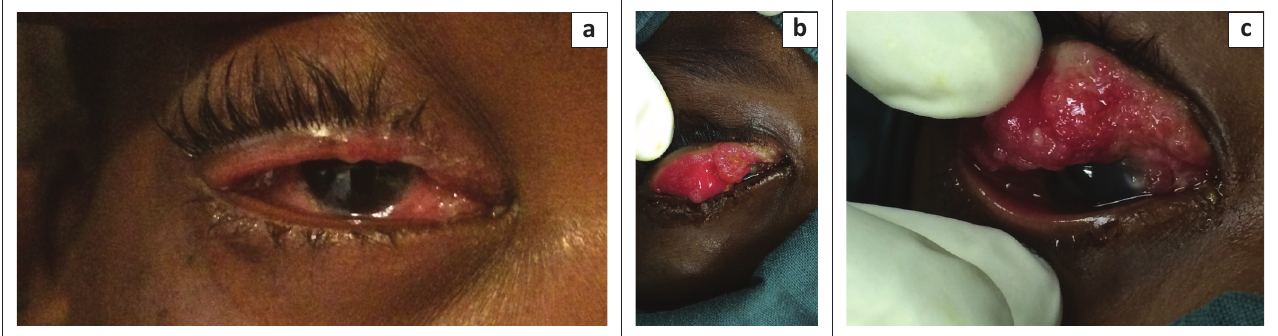
FIGURE 2: (a) Mattered lashes, mardarosis nasally and a mucopurulent discharge; (b) irregular granulomatous masses on the upper palpebral conjunctiva; and (c) ulcerated corneal phlyctenule at